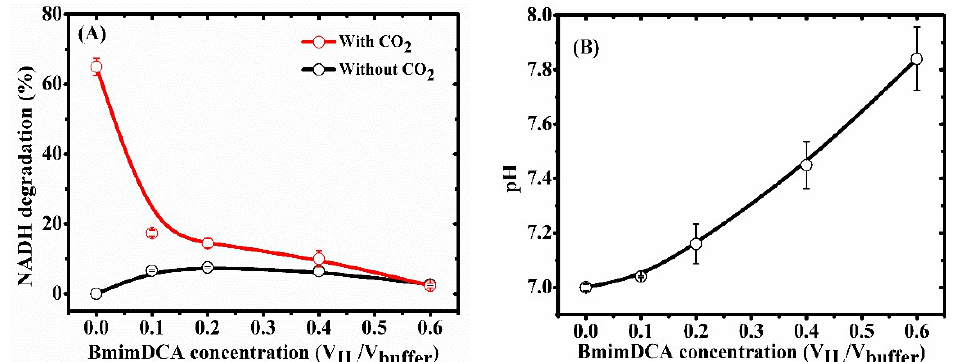
Figure 6. Effect of CO 2 on degradation of NADH in BmimDCA. ( A ) Degradation of NADH with CO 2 and without CO 2 ; ( B ) pH of solution at different concentrations of BmimDCA; General conditions: NADH in contained-BmimDCA buffer for 3 h at 37 °C; NADH (1.4 mg, 2 μmol); CO 2 (1 bar); Buffer (2 mL).